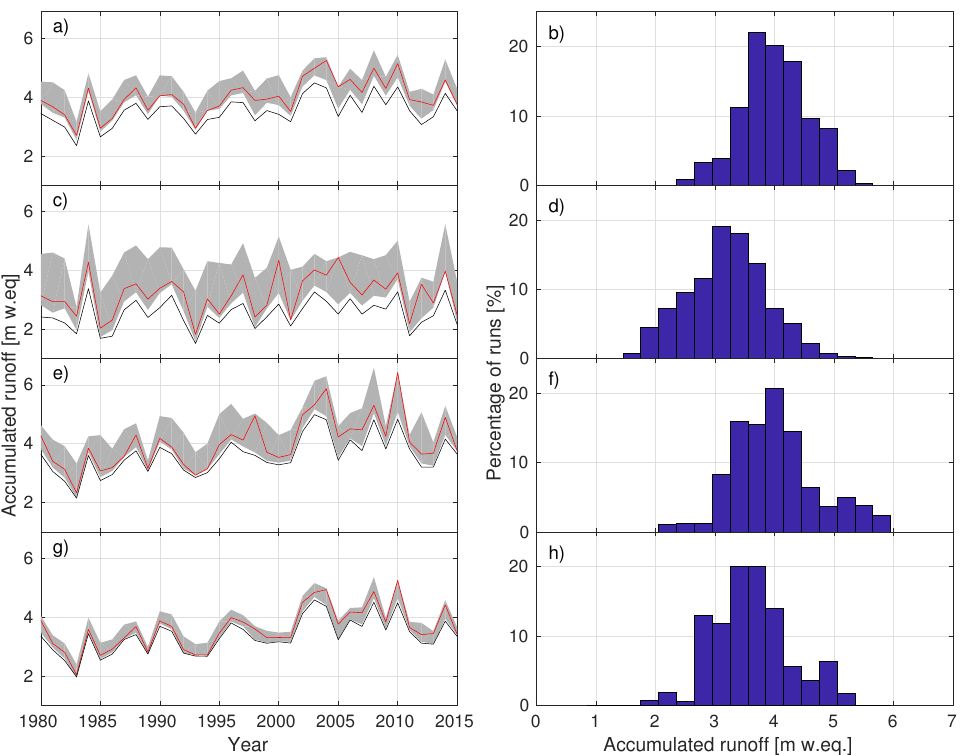
Figure 8. Time series of accumulated runoff for April–October from ( a ) Vatnajökull; ( c ) Brúarjökull; ( e ) Síðujökull; ( g ) Skaftá GWC for different spring conditions. The red line is the original run where the spring conditions of the specific year are used, the grey area shows the range in runoff when the spring conditions are changed, and the black line shows how much melt would occur if the underlying ice is never exposed. Probability distributions for the runoff created using the results of the sensitivity runs are shown for ( b ) Vatnajökull; ( d ) Brúarjökull; ( f ) Síðujökull; ( h ) Skaftá